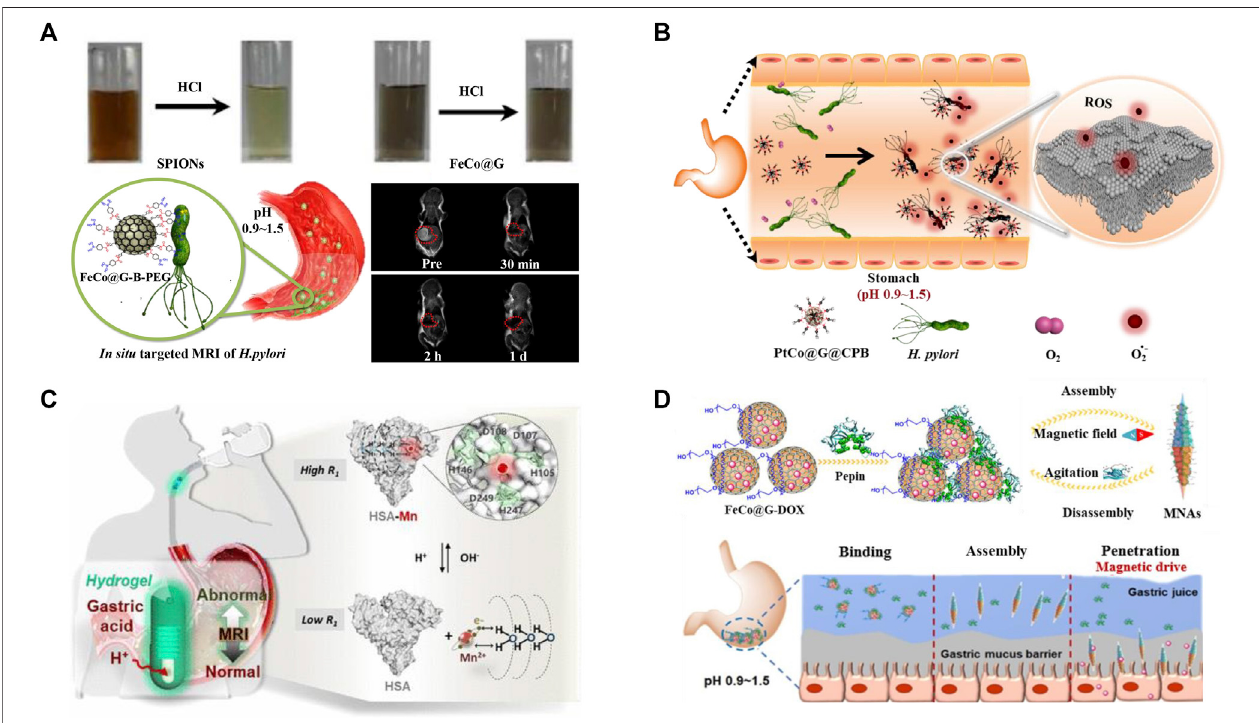
FIGURE2| Metalgraphiticnanocapsules-basedtheranosticsinharshstomachconditions. (A) StabilityofFeCo@Gin1 MHClandFeCo@G-B-PEGfor insitu MRI imagesof H.pylori (Lietal.,2017). (B) CoPt@G@CPBplatformfortargetedandselectivecombating H.pylori infection invivo (Zhangetal.,2021b). (C) Hydrogelisolated HSA-Mn system for MRI monitoring of gastric pH (Xu et al., 2021). (D) Pepsin-assisted assembly of FeCo@G for enhanced mucosal penetration depth and prolonged drug retention (Cai et al.,